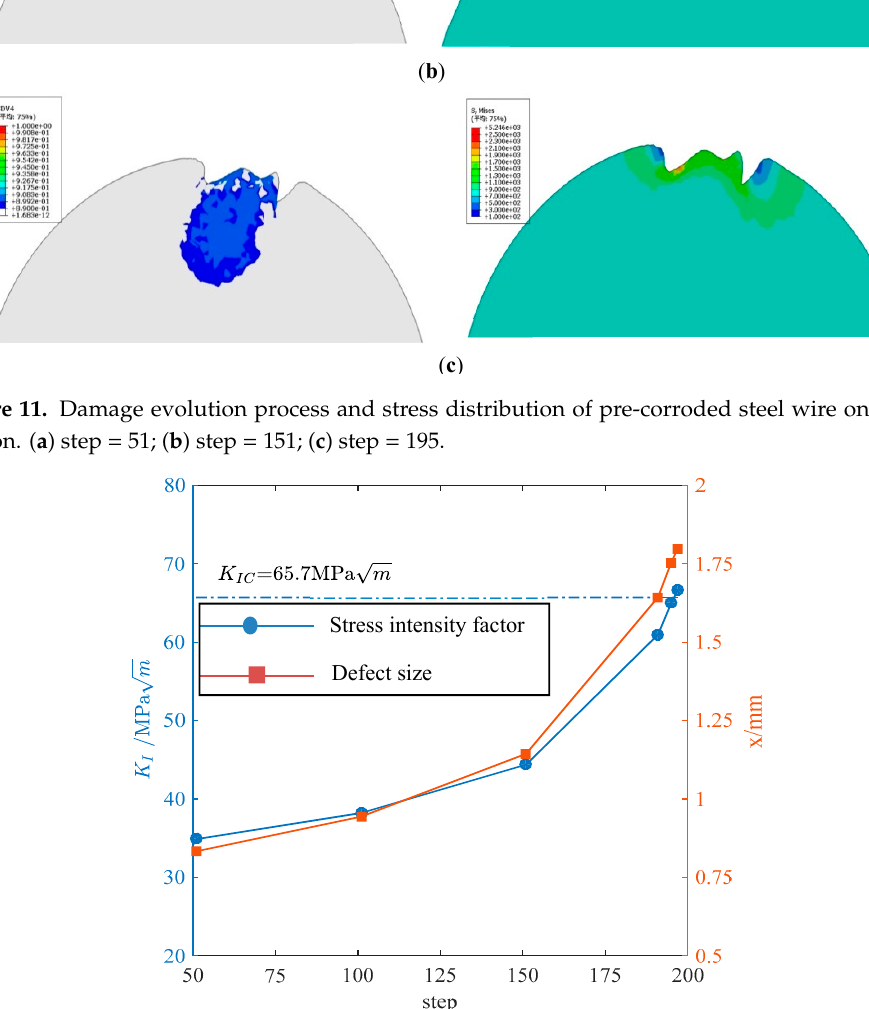
Figure 12. Time-varying curves of the stress intensity factor and defect size in steel wire.